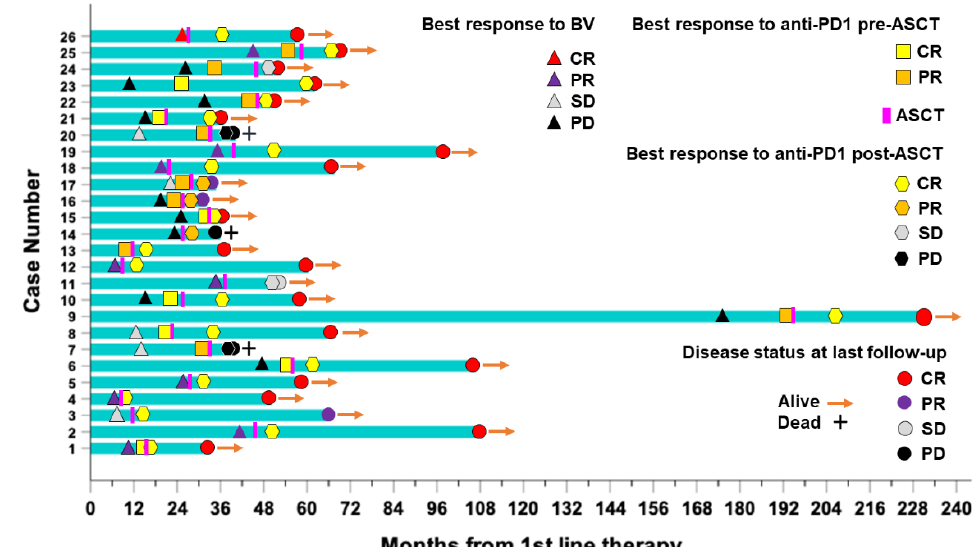
Figure 5. Swimmer’s plot of 26 high-risk patients with RR-HL who received consolidation with PD1- blockade after autologous stem cell transplantation (ASCT). Best responses (CR, complete response; PR, partial response; SD, stable disease; PD, progressive disease) to brentuximab vedotin (BV) and anti-PD1 treatment before (pre-ASCT) and after ASCT (post-ASCT), disease status and survival (alive/dead) at last follow-up are indicated accordingly. Bars represent the timeline (months) from upfront therapy for each patient included in the study.